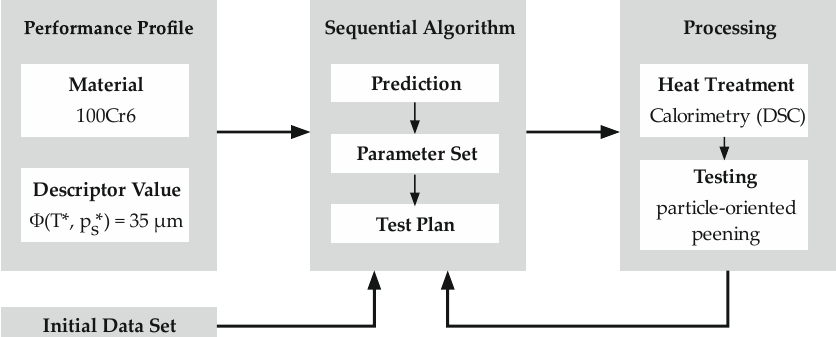
Figure 3. Procedure for the iterative determination of process parameters.